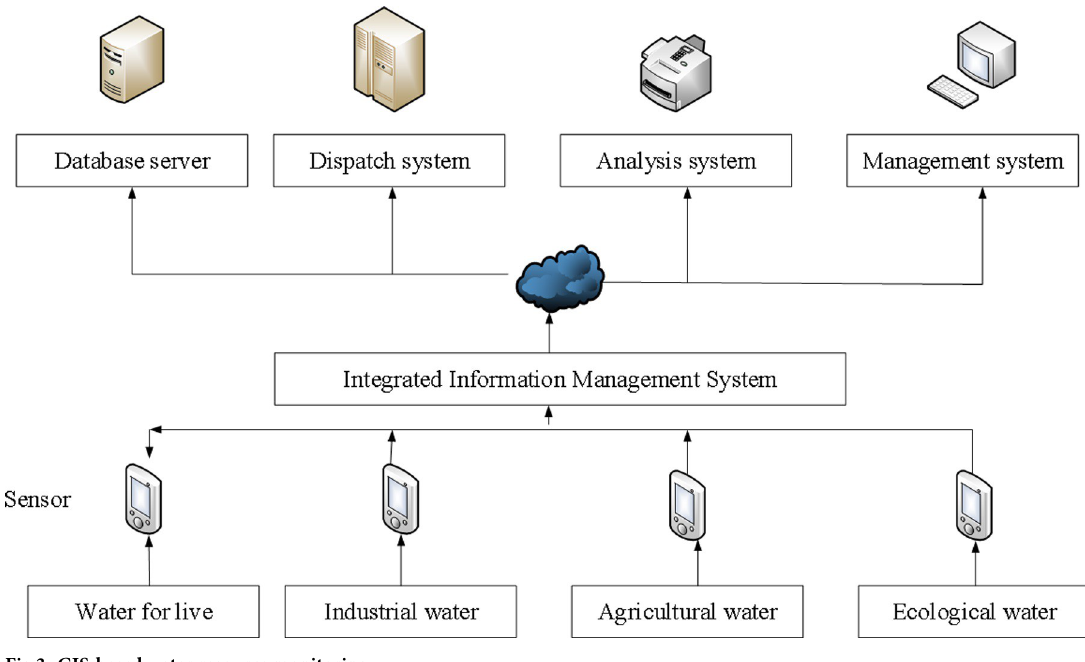
Fig 3. GIS-based water resource